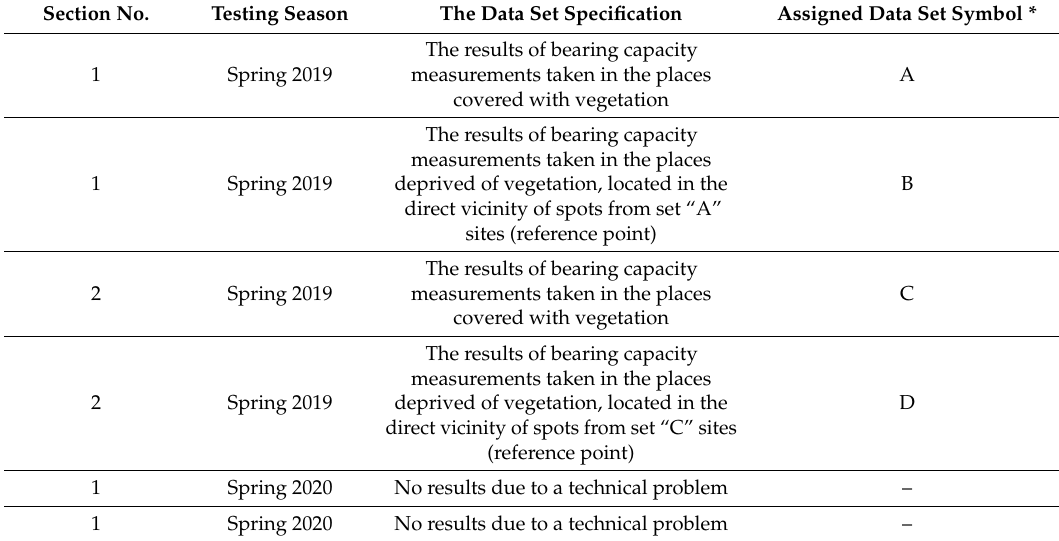
Table 2. The analyzed data sets and adopted coding